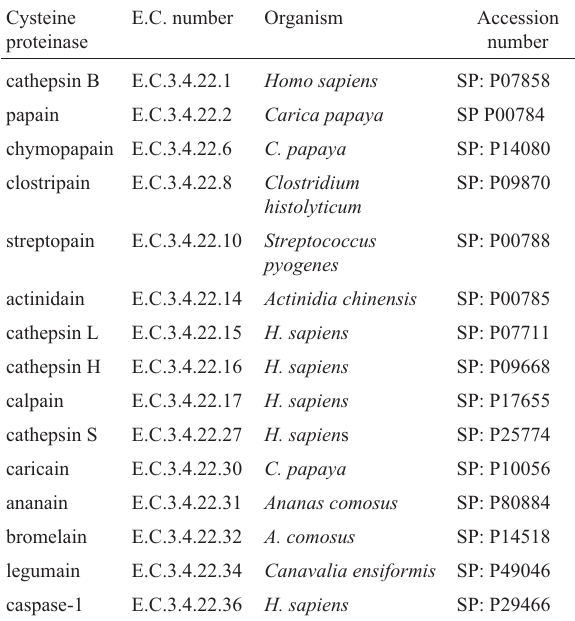
Table I - Cysteine proteinase official name, E.C. number, scientific name of the organism and accession number of the cysteine proteinases used in this